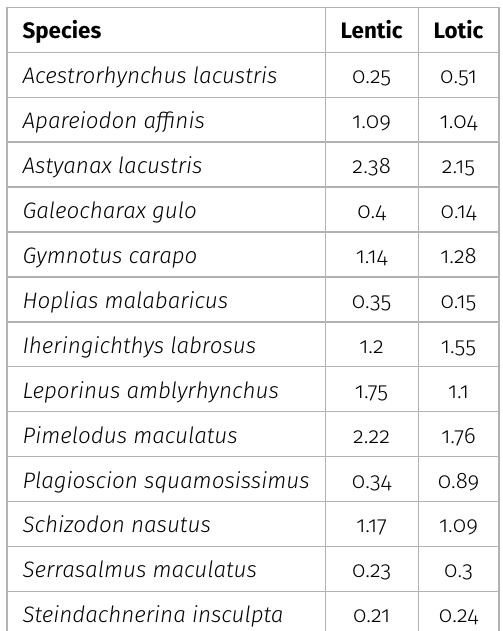
Table IV. Trophic niche breadth values (B) of fish species in the lentic and lotic stretches of the Chavantes Reservoir, middle Paranapanema River, state of São Paulo,